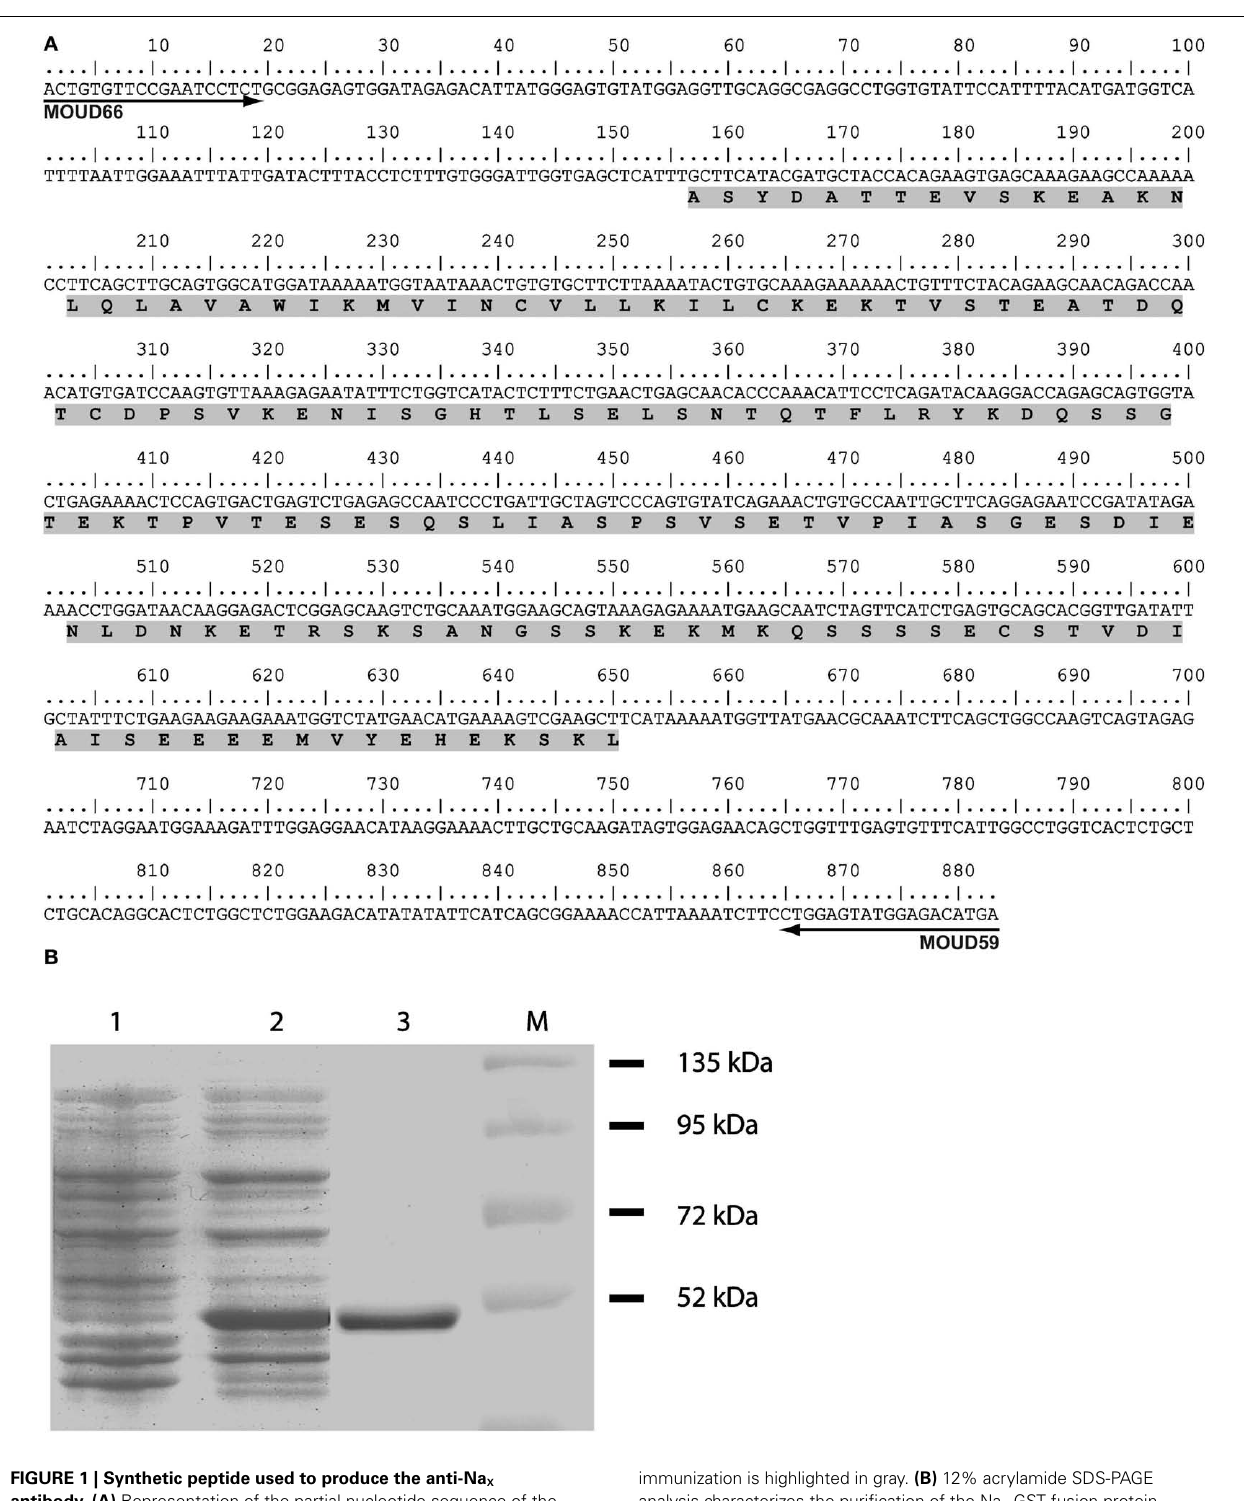
immunization is highlighted in gray. (B) 12% acrylamide SDS-PAGE analysis characterizes the purification of the Na X -GST fusion protein. Lanes contain non-induced crude lysate (1), 0.1mM IPTG-induced crude lysate (2) and purified 49kDa Na X -GST fusion protein (3). M, protein size